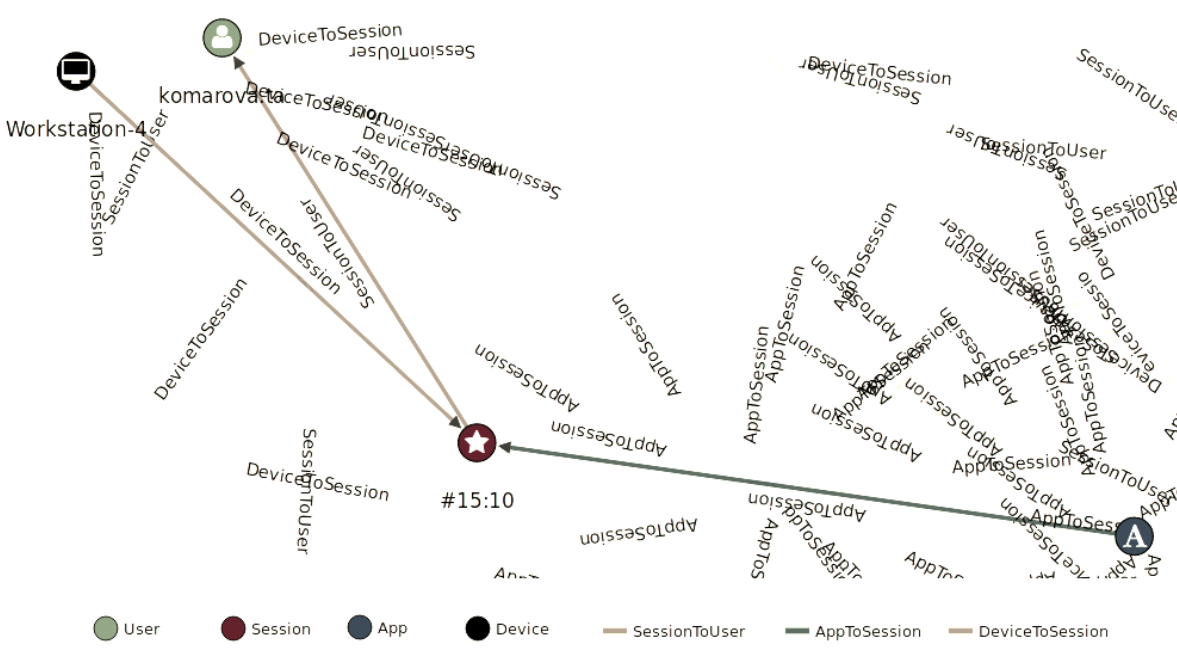
Figure 7. Sample for a specific session.